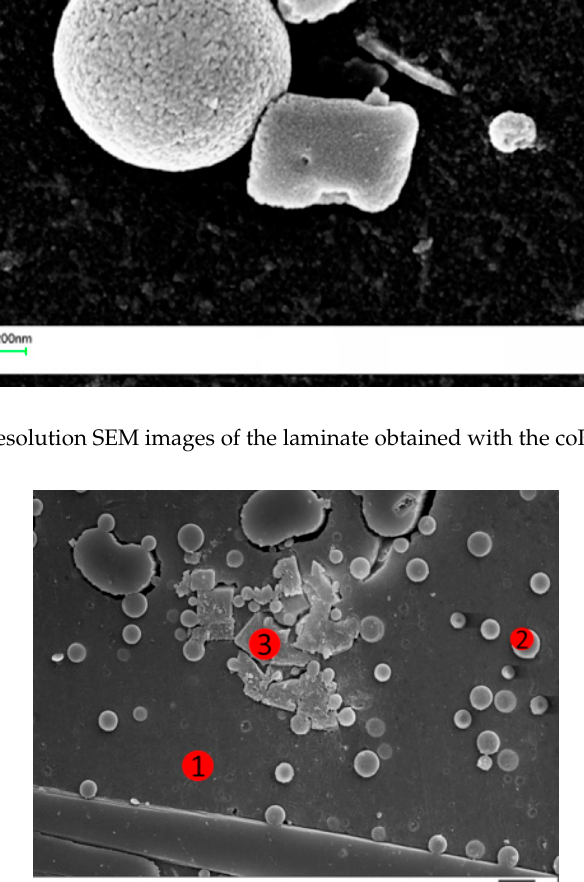
Figure 11. SEM images of the region analyzed by EDX for the laminate obtained with the coPES/1% POSS veil. Table 2. EDX analysis for the zones of the interlaminar region (see Figure 10) analyzed by EDX for the laminate obtained with the coPES/1% POSS veil.